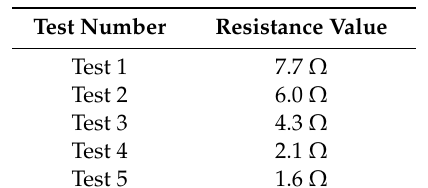
Table 11. Resistance value for the tests.